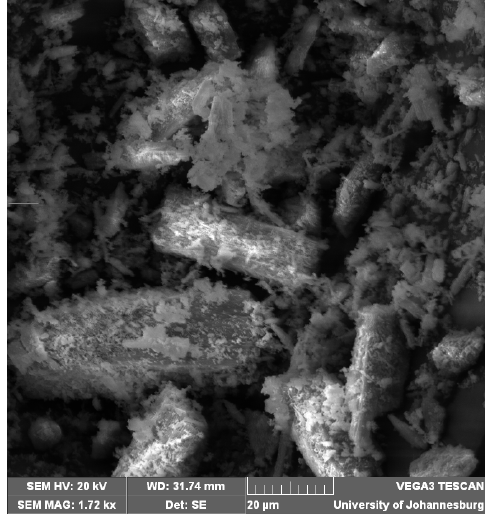
Figure 2. SEM micrograph of the adsorbent.